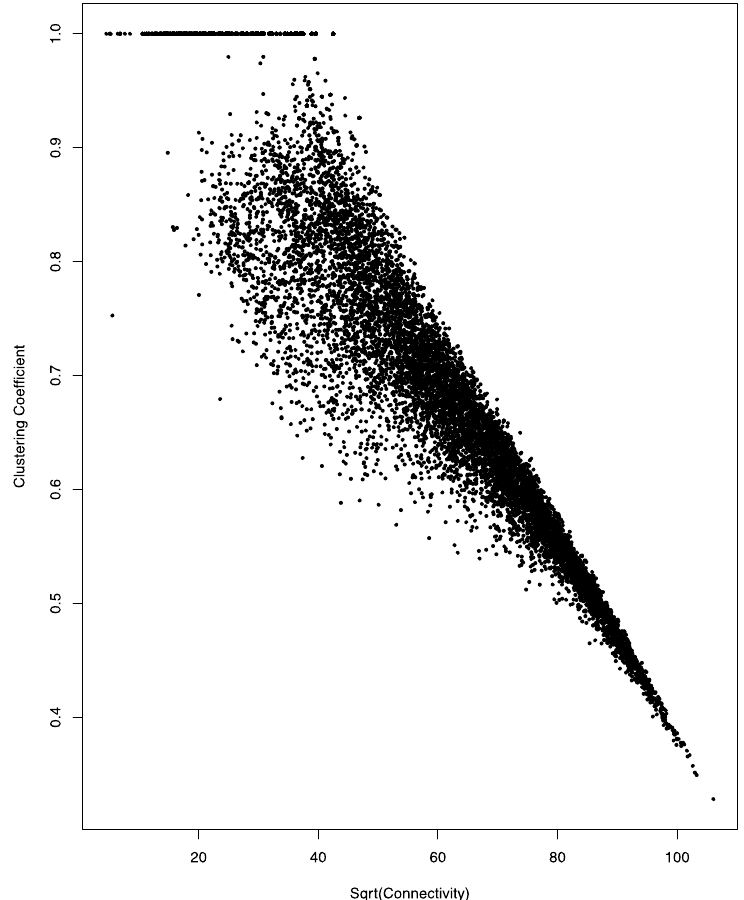
Figure 2. Negative correlation between connectivity and clustering coefficient in the miRNA co-regulation network. A scatter plot of the square root (sqrt) of connectivity and clustering coefficient is shown. The linear relationship has a correlation coefficient of 0.94.